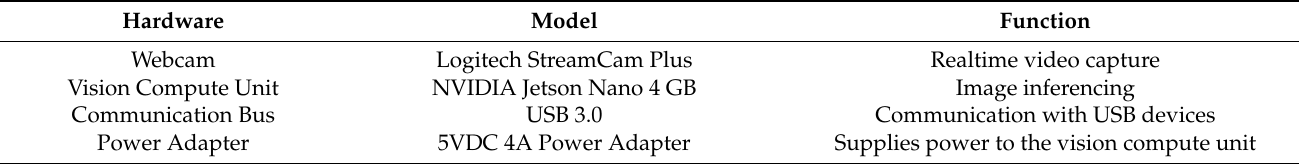
Table 2. Summary of vision module hardware.